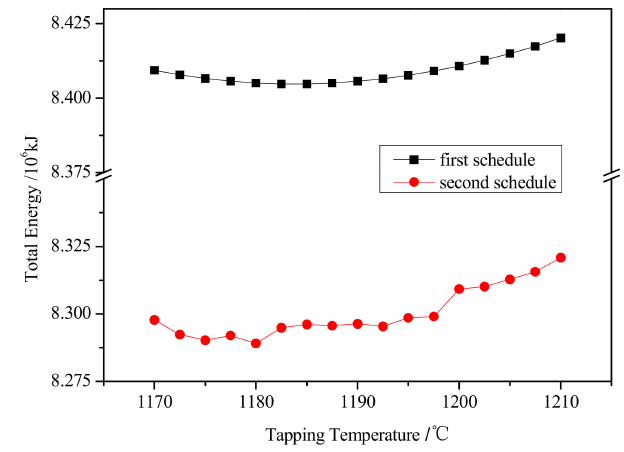
Figure 7. Comparison of total energy between the actual schedule and optimized schedule (1170–1210 ◦ C).